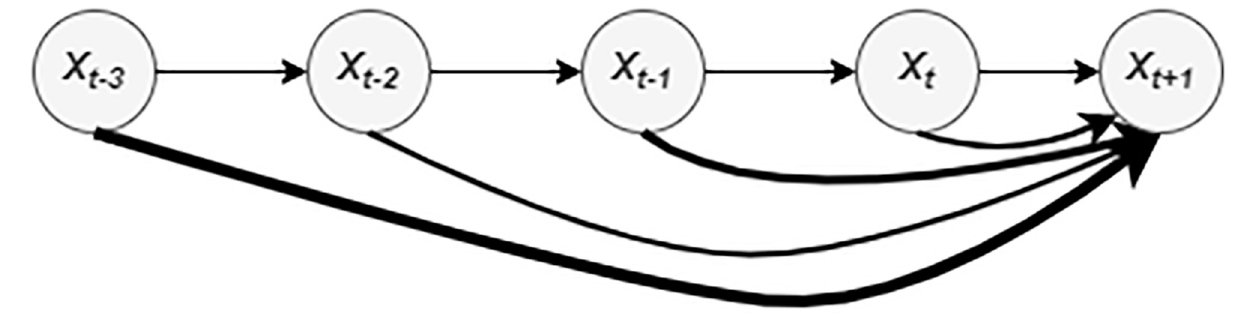
Fig 4. An illustration of the attention